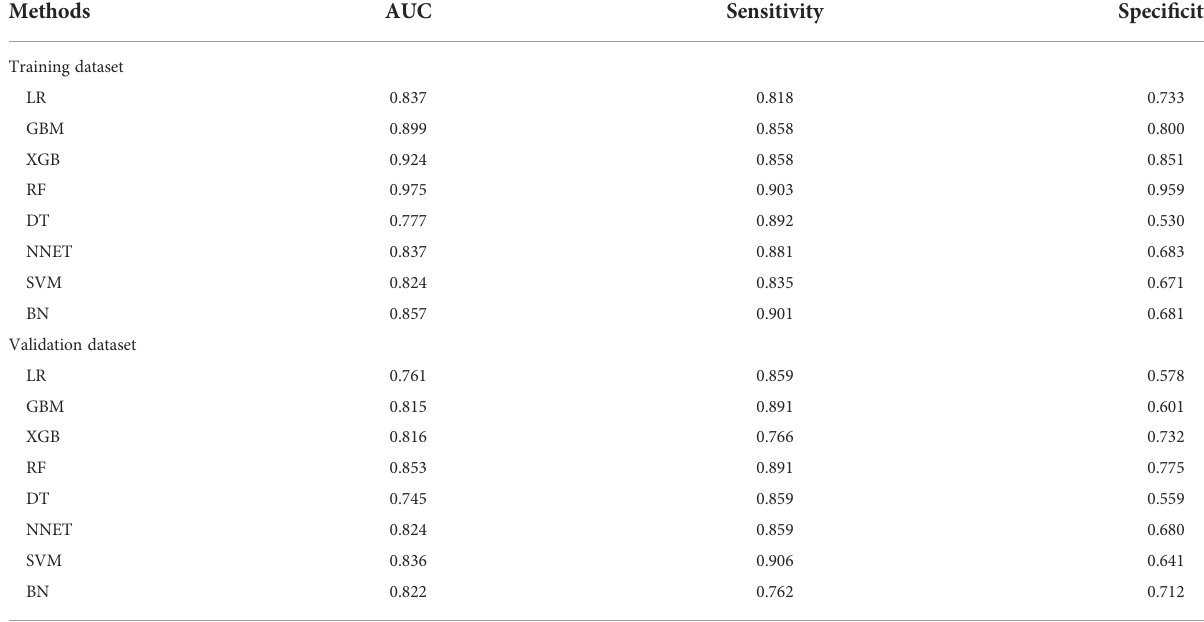
TABLE 3 Predictive performance comparison of the eight types of machine learning algorithms in the training and validation dataset.